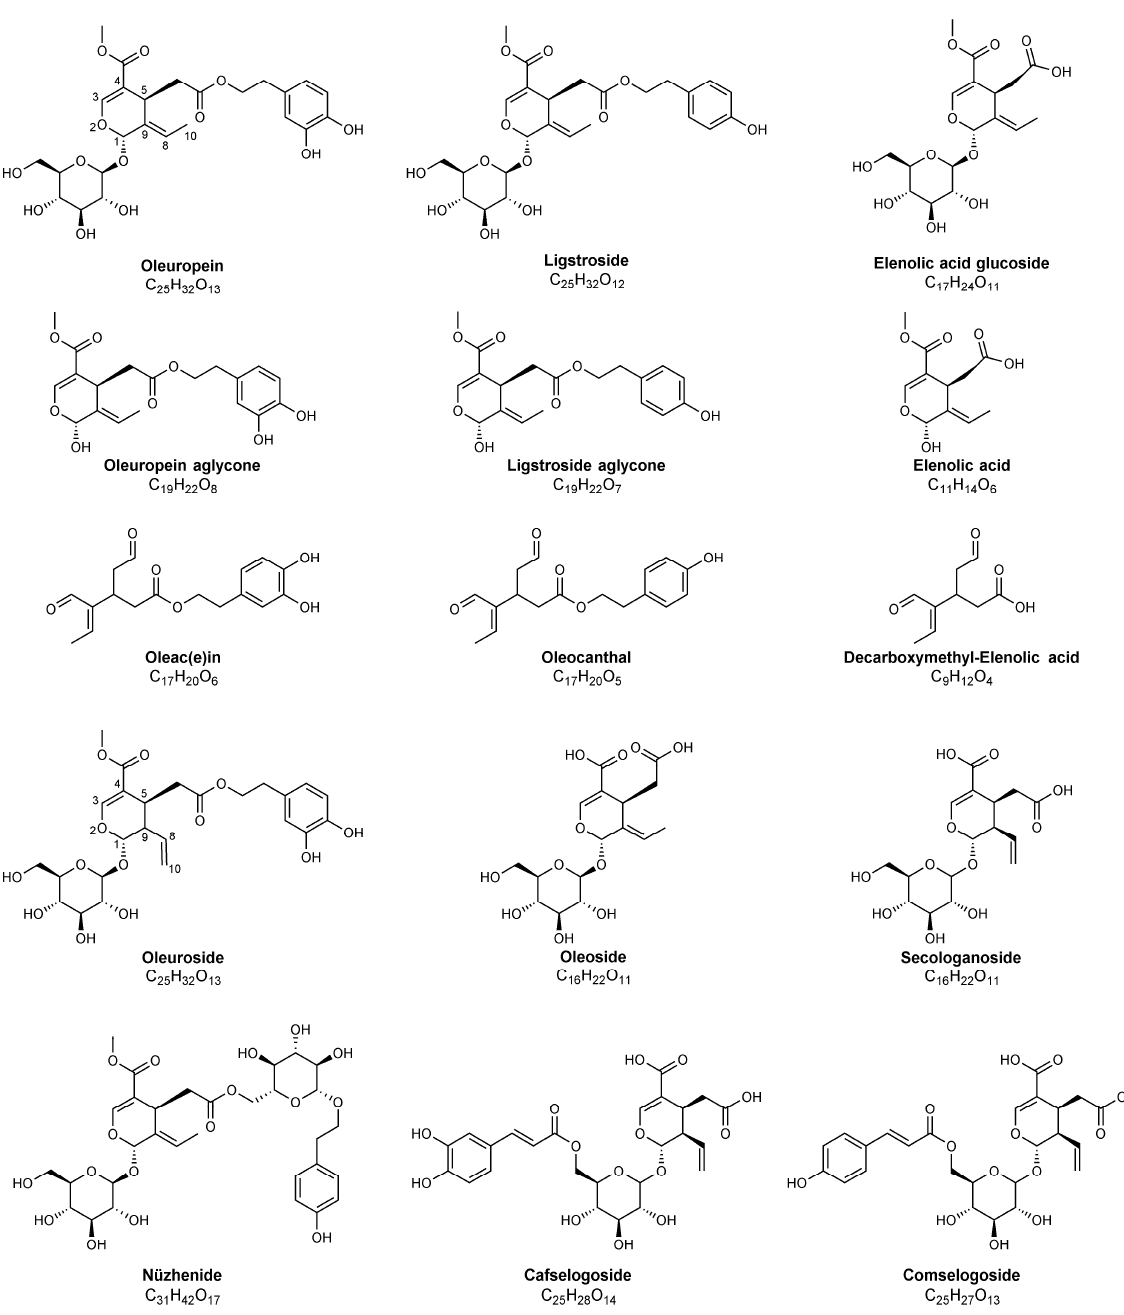
Figure 2. Chemical structures of major secoiridoids identified in olive leaves, pomace and in olive oil mill wastewater using MS techniques. Note that hemiacetalic forms of elenolic acid and of oleuropein and ligstroside aglycones are reported; dialdehydic open-structure isoforms are indicated for oleac(e)in, oleocanthal and decarboxymethyl-elenolic acid. The carbon atoms numbering typically adopted for secoiridoids has been reported for oleuropein and oleuroside to emphasize the positional isomerism occurring for these compounds, related to the position of the exocyclic C=C bond.